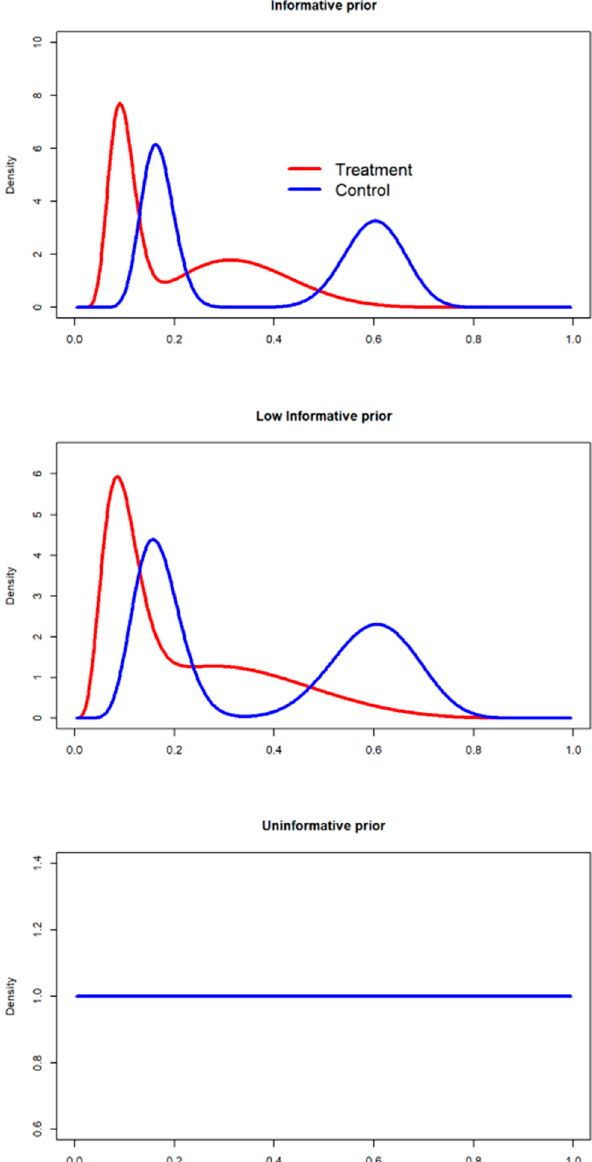
Figure 1. Prior distributions: The prior distributions are defined by an equal-weighted mix- ture ( γ = 0.5) of beta priors. The components of the mixture prior are, for the treatment arm, Π ∼ Beta ( 6,12 ) and Π ∼ Beta ( 12,111 ) . The mixture of priors ( γ = 0.5 ) for the control arm is defined by Π control ( Huang ) ∼ Beta ( 39,26 ) and Π control ( Shaikh ) ∼ Beta ( 22,109 ) . No discounting on the beta priors parameters has been provided (d 0 = 1) for the Informative priors. The information has been partially discounted for the low-informative prior scenario (d 0 = 0.5). The priors parameters are full discounted for the uninformative prior scenario (d 0 = 0), collapsing to a Beta ( 1,1 ) distribution.